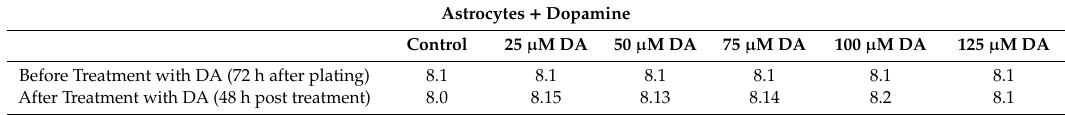
Table 1. pH readings in astrocyte cultures before and after administration of dopamine.